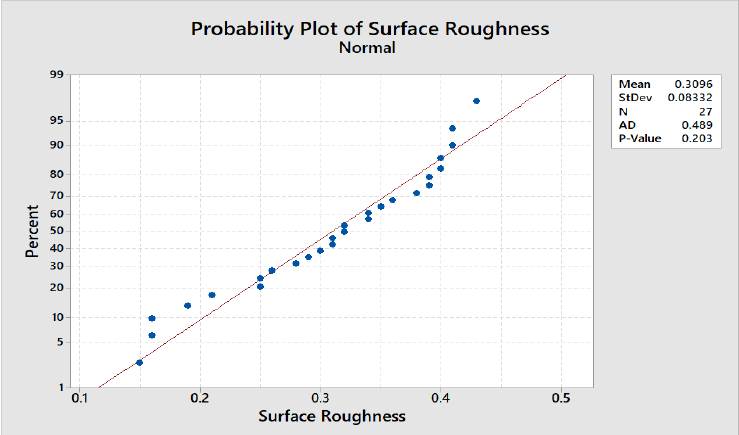
Figure 12. Normality plot of surface roughness.